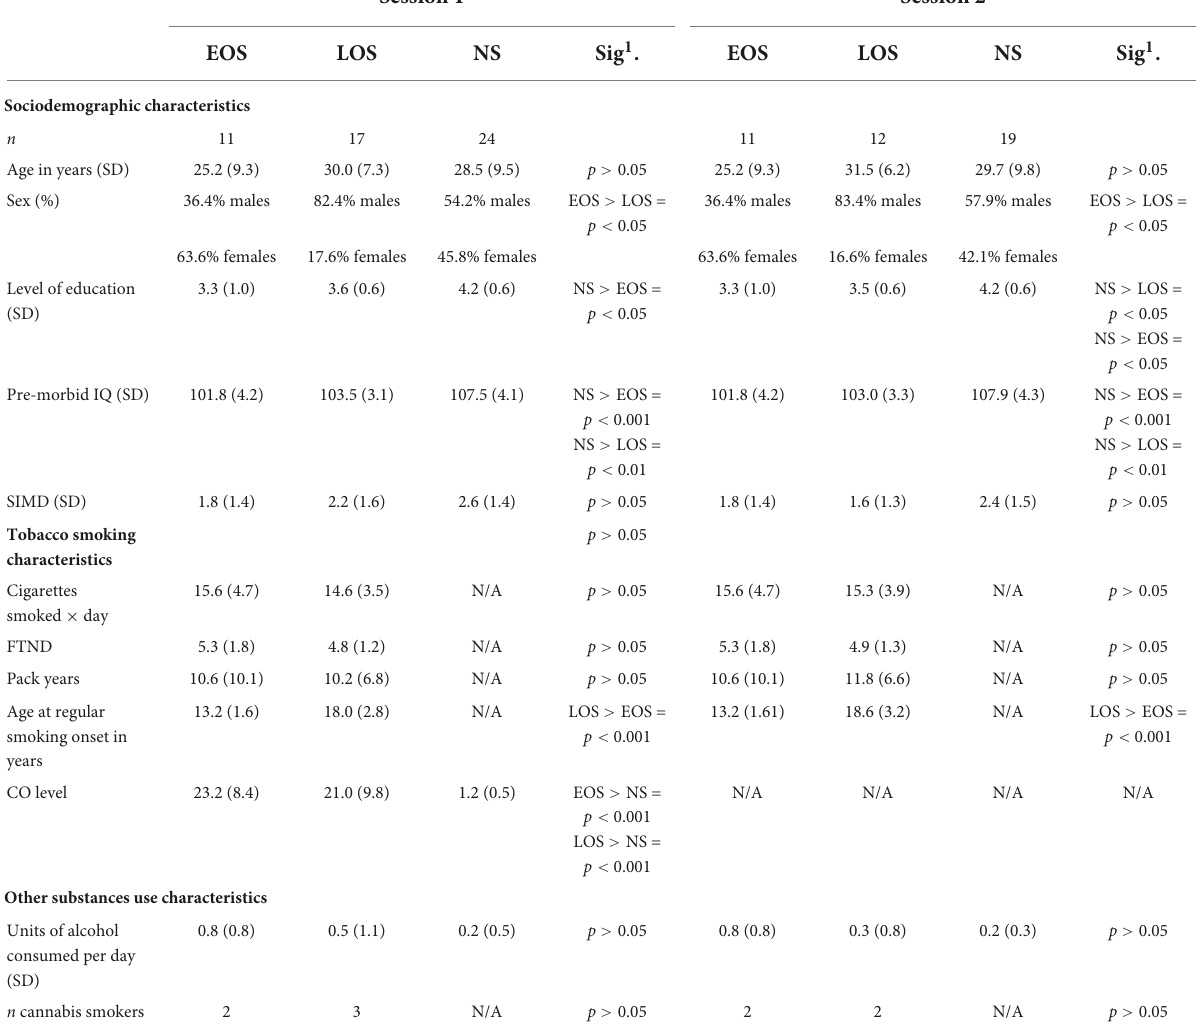
TABLE 2 Socio-demographic characteristics and tobacco smoking characteristics of participants. Session